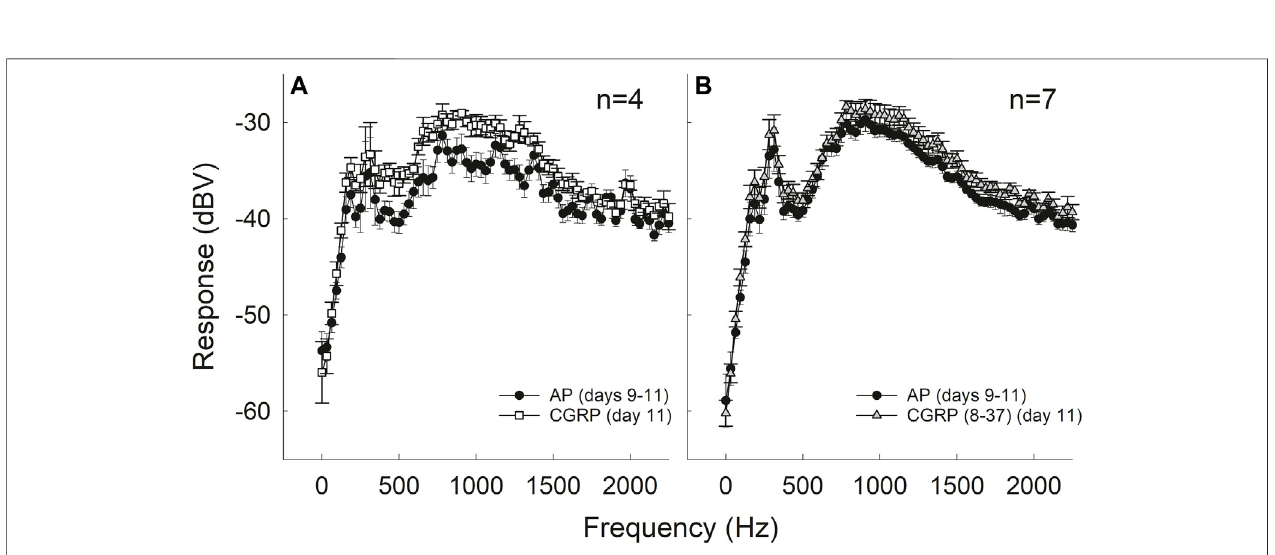
FIGURE4| Intra-cochlearinfusionofCGRP enhanced round window noisefromapproximately 500 – 1,200 Hz;thefrequencyrange associatedwithspontaneous fi ring of the auditory nerve (A) . There were no changes in round window noise during infusion of CGRP (8 – 37) (B) .